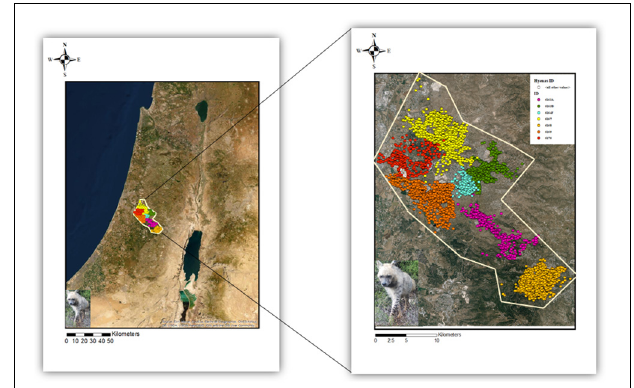
FIGURE 1 | Study area in the central district of Israel. GPS locations for each of the seven striped hyenas are marked in distinct colors. 6163A, 6163B, 6164F, and 6170 are females, while 6167, 6168, and 6169 represent males’